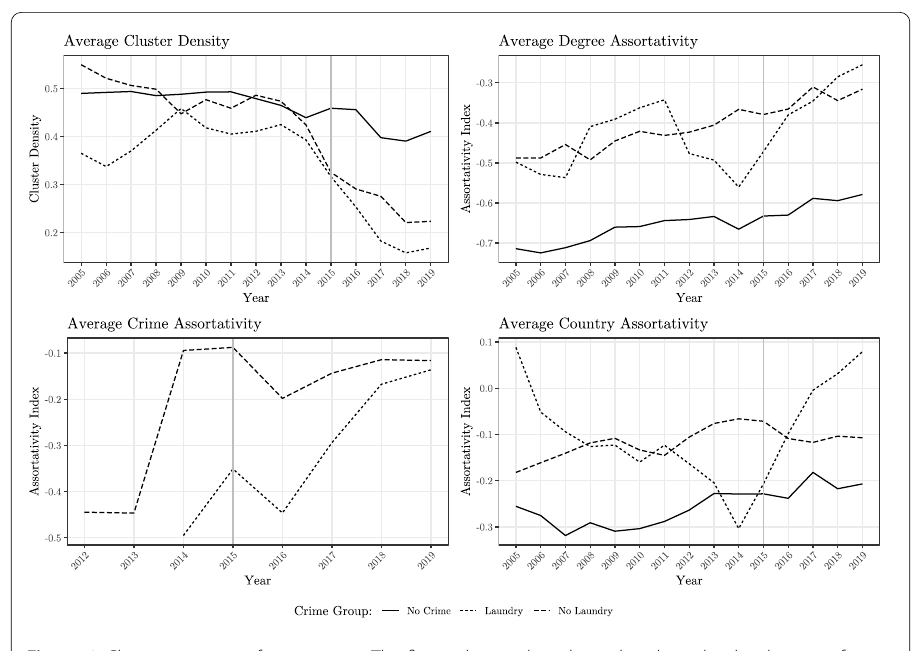
Figure 6 Cluster measures of connectivity. This figure shows 4 line charts that show the development for each cluster type on average cluster density, average degree assortativity, average crime assortativity and average country assoertativity